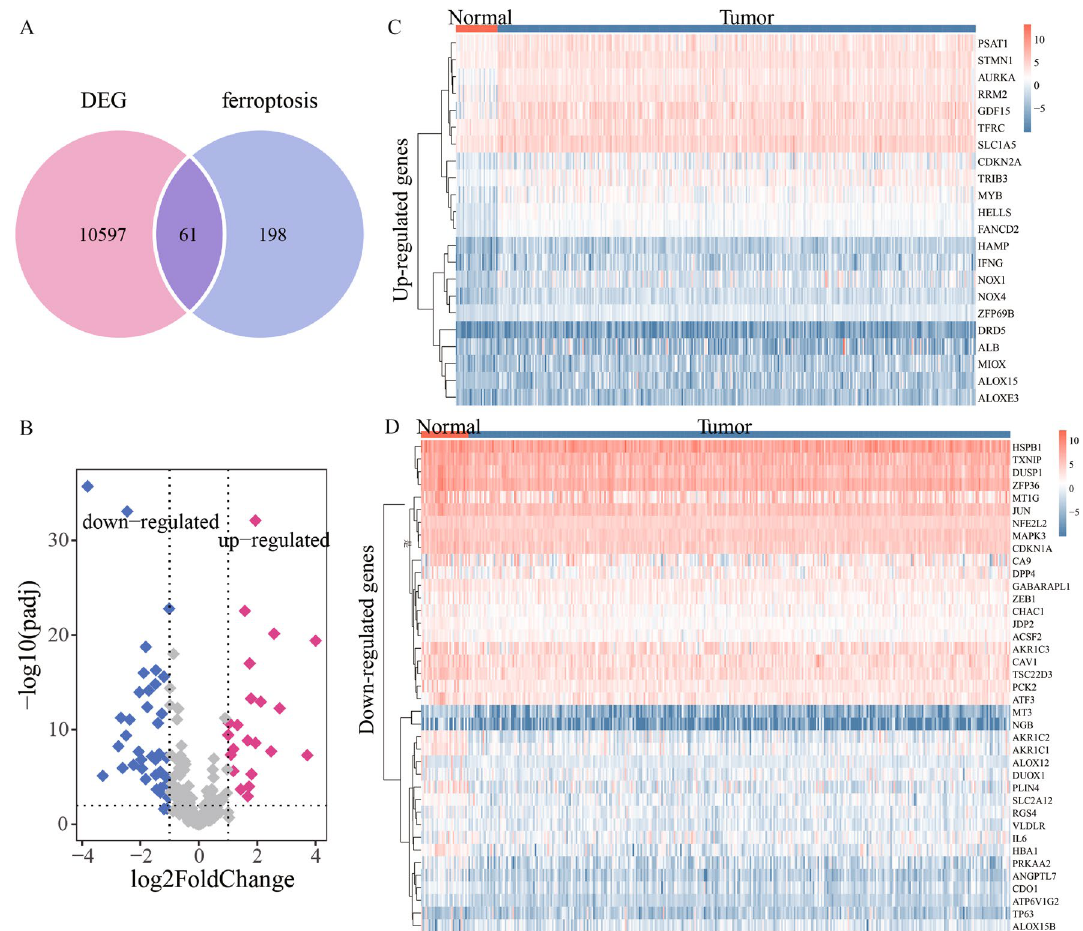
Figure 1. ( A ) The differentially expressed genes (DEGs) associated with ferroptosis in gastric cancer. ( B ) The upregulated genes with padj < 0.05 and log2FoldChang > 1 and the downregulated genes with padj < 0.05 and log2FoldChang < (−1). ( C and D ) Heatmaps of 22 upregulated genes and 39 downregulated genes in 343 tumor and 30 normal tissues from GC. The row represents the gene expression value of each gene, and the column represents each sample. The redder the color, the higher the gene expression value. The bluer the color, the lower the gene expression